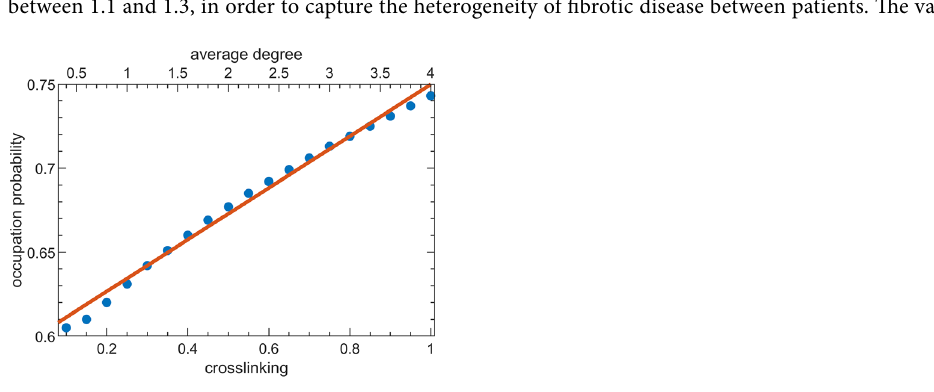
Figure 5. Occupation probability at the bond percolation threshold as a function of cross-linking fraction, ρ (translated into average network degree along the top horizontal axis). The orange line shows the linear fit to these data. The bond percolation thresholds corresponding to the symbols were taken from the inflection points of the curves shown in Fig. 6 respective to their cross-linking